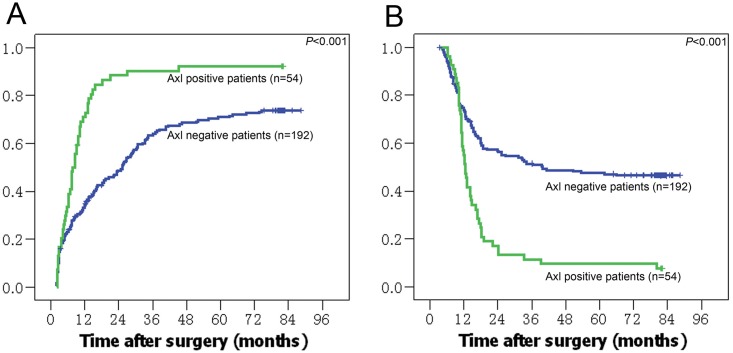
AXL expression and its association with prognosis in HCC patients.A, B: Kaplan-Meier curve of TTR and overall survival rates in patients with positive and negative AXL staining, respectively.